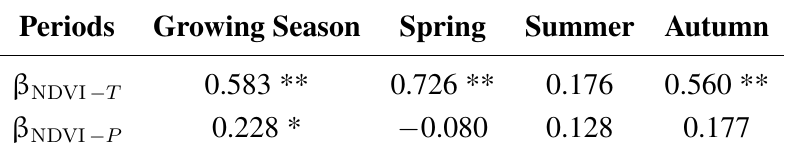
Figure 8. Map of regression coefficients between the growing season mean NDVI and ( a ) growing season mean temperature; ( b ) growing season total precipitation. Light gray pixels are masked out according to land cover and dark gray pixels show insignificant trends. Table 2. Relative effects of temperature ( β ) and precipitation ( β ) on NDVI NDVI − T NDVI − P during the growing season, spring, summer and autumn at a national scale from 1982 to 2010. Significant coefficients verified with t-test are noted with “**” under significance level of 0.05 and noted with “*” under significance level of